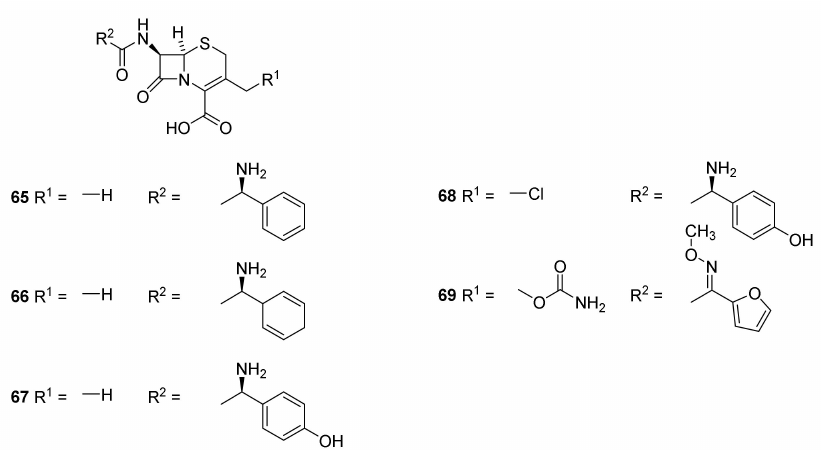
Figure 16. Examples of first generation cephalosporins. Cephalexin ( 65 ), cefadrine ( 66 ) and cefadroxil ( 67 ). Second generation cephalosporins cefalclor ( 68 ) and cefuroxime ( 69